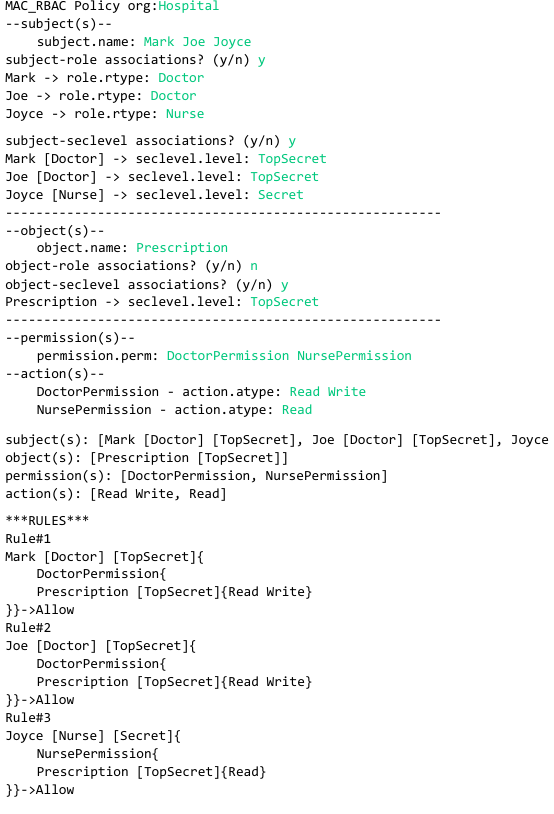
Figure 25. Example 2: Generating MAC/RBAC